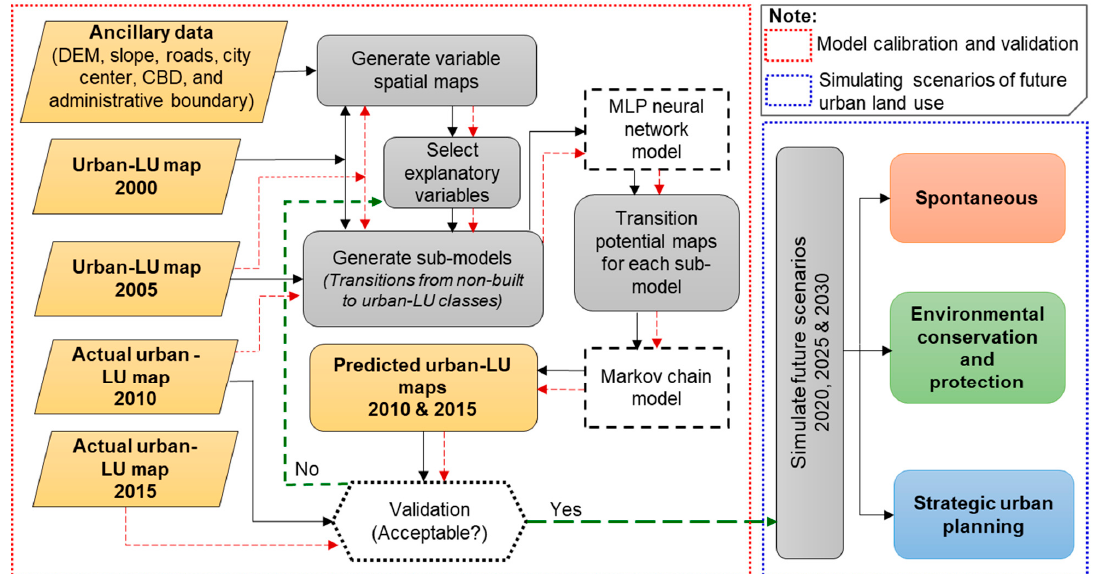
Figure 2. Modeling framework for simulating scenarios of future intra-urban-LU expansion of Lusaka city, Zambia. Note: intra-urban-LU maps for 2000 and 2005 were used for calibration and simulation to 2010 (black arrows), while intra-urban-LU maps for 2005 and 2010 were used for calibration and simulation to 2015 (dashed red arrows).